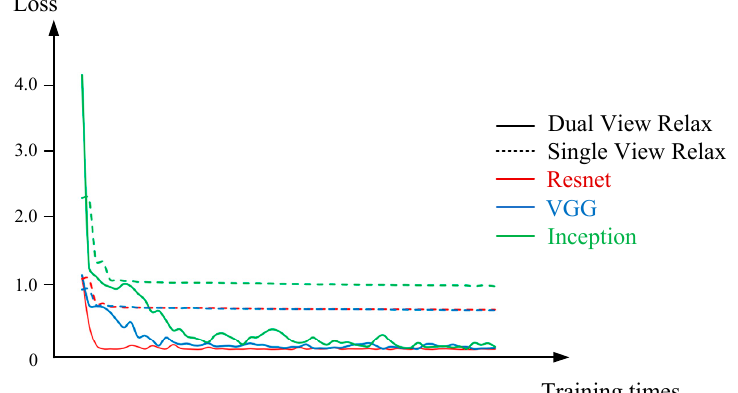
Figure 14. Variation of loss during network training.